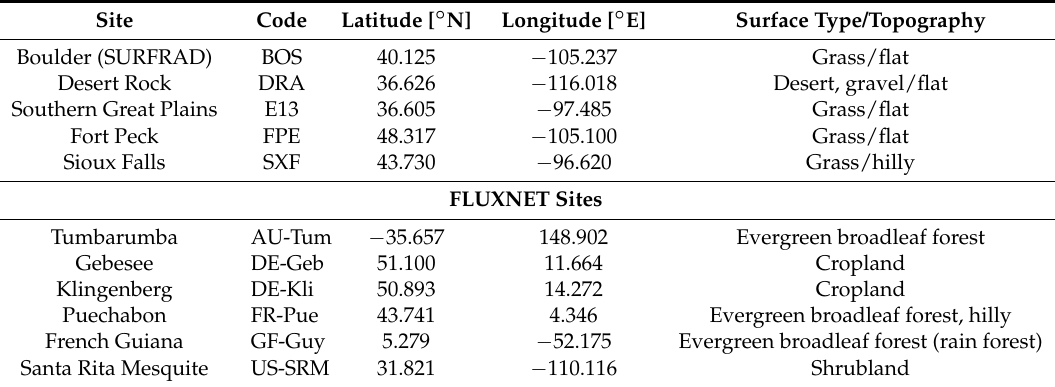
Table 3. The BSRN and FLUXNET evaluation sites of this